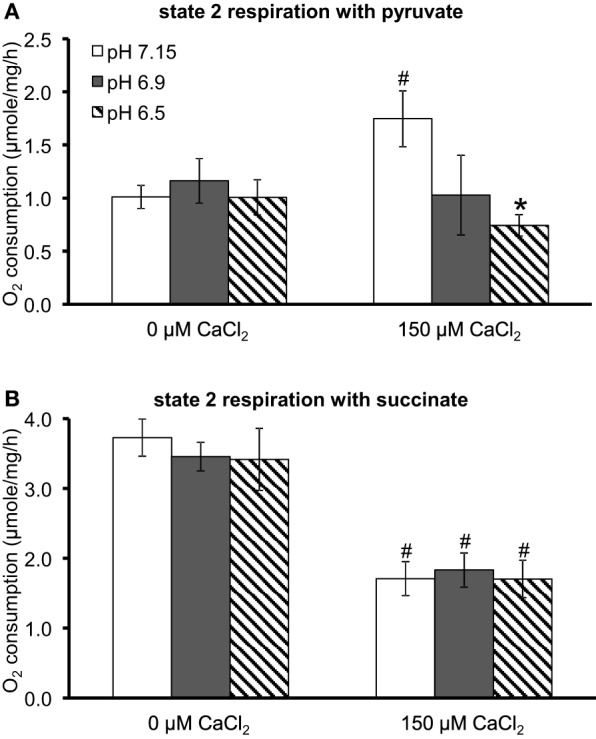
Summary of the effects of pH and added CaCl2 on O2 consumption (μmol/mg/h) during state 2 respiration in (A) pyruvate-energized and (B) succinate-energized mitochondria. P < 0.05 *Significant difference in O2 consumption at pH 6.9 or pH 6.5 vs. pH 7.15 within the same CaCl2 group. #Significant difference in O2 consumption in 150 μM CaCl2 vs. 0 μM CaCl2 for each pH group. O2 consumption was measured in a respirometer. N = 4 each.